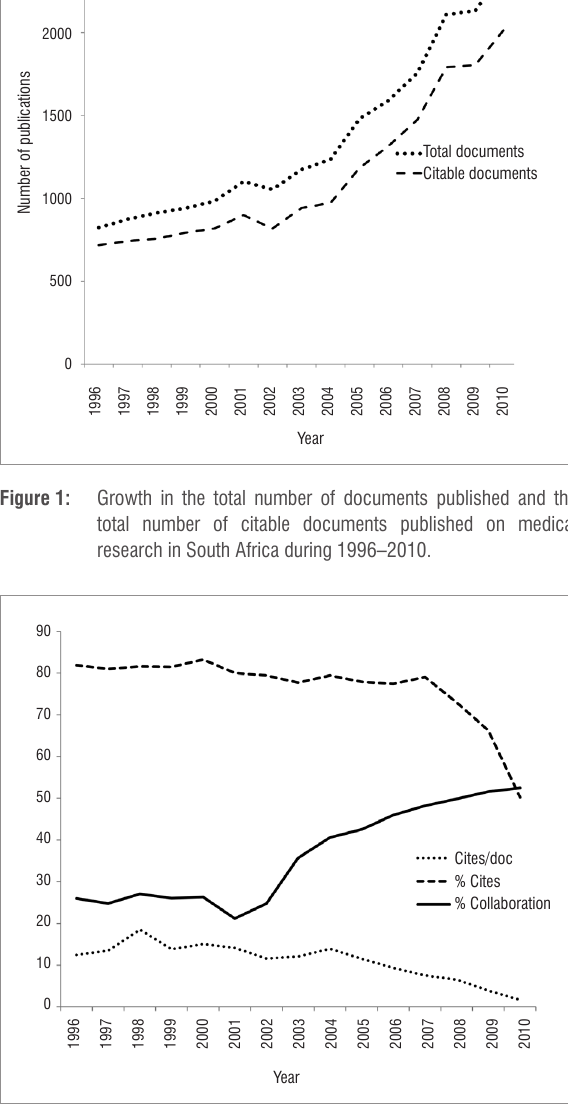
Figure 2: Changes in South African medical scholarly output – measured by the number of citations/document, percentage citations and percentage of international collaboration – during 1996–2010.